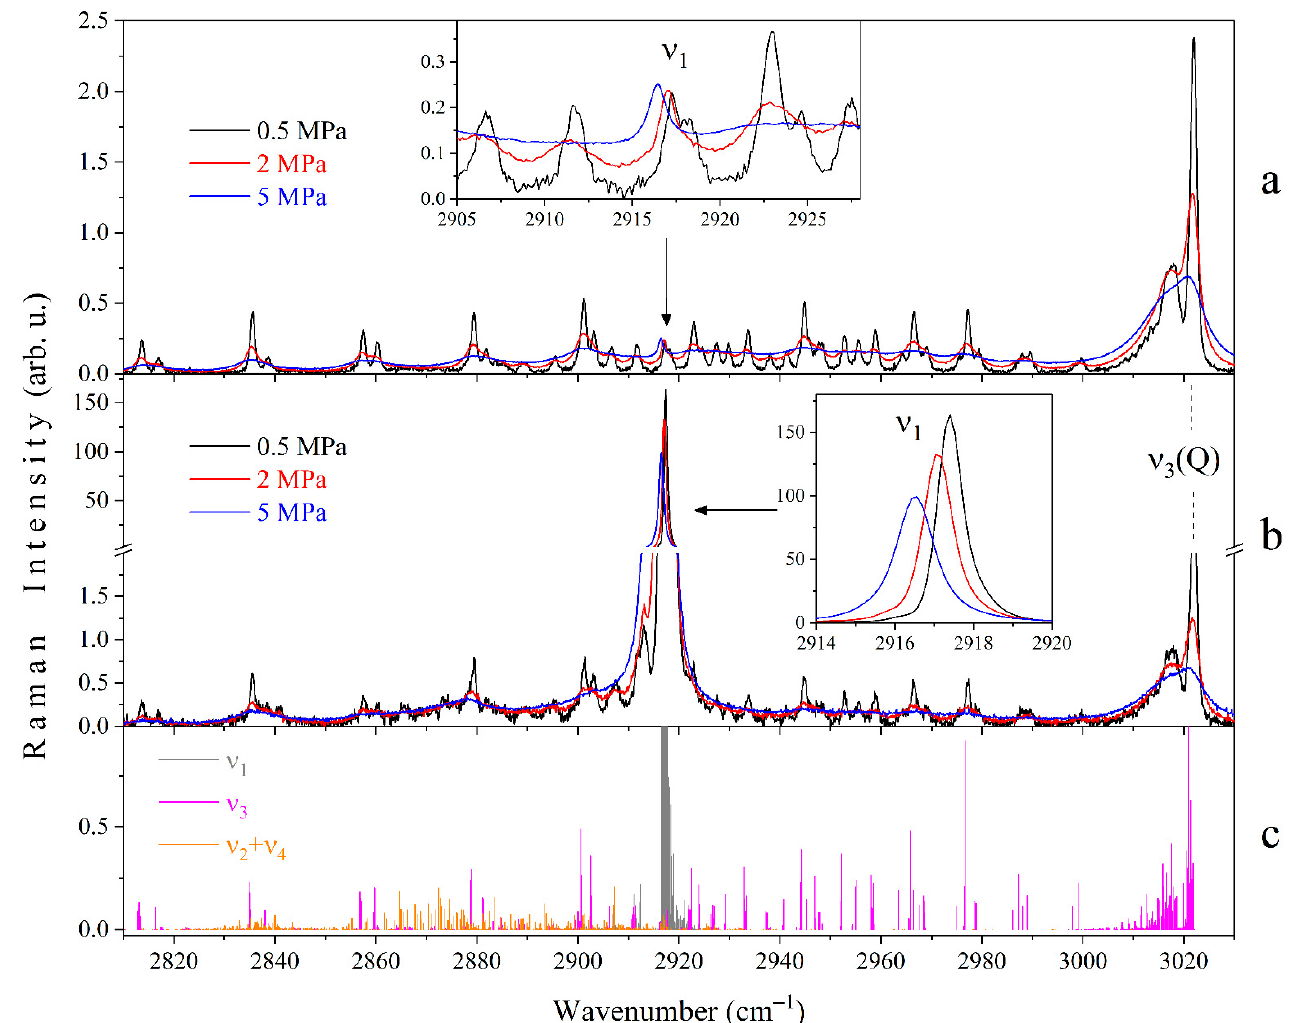
Figure 2. Experimental depolarized ( a ) and polarized ( b ) Raman spectra of pure CH 4 at pressures of 0.5, 2, and 5 MPa. The spectra are normalized by the integrated intensity of the Q branch of the ν 3 band. The insets show the effect of pressure on the ν 1 peak. Panel ( c ) shows the positions and intensities of the rotational-vibrational lines of the ν 1 , ν 3 , and ν 2 + ν 4 bands calculated by Ba et al. [52].